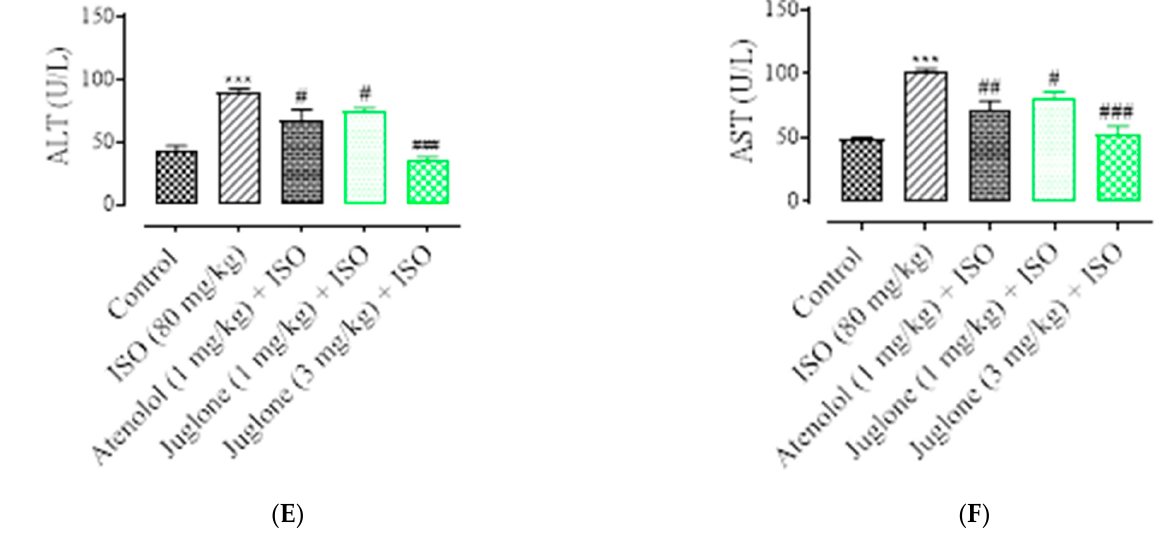
Figure 5. Effect of juglone and atenolol on cardiac troponin I (cTnI) ( A ) creatine phosphokinase (CPK) ( B ), creatine kinase-MB (CK-MB) ( C ), lactate dehydrogenase (LDH) ( D ), alanine transaminase (ALT) ( E ) and aspartate transaminase (AST) ( F ) in isoproterenol (ISO)-induced ischemic rats. Values are expressed as mean ± SEM (n = 6), where # p < 0.05 vs. ISO, ## p < 0.01 vs. ISO, ### p < 0.001 vs. ISO and *** p < 0.001 vs. control (one-way ANOVA followed by a Tukey’s test).